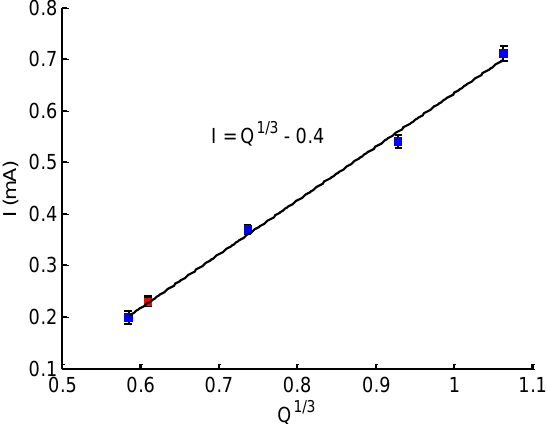
Figure 6. Calibration curve of the electrode current I as a function of the flow